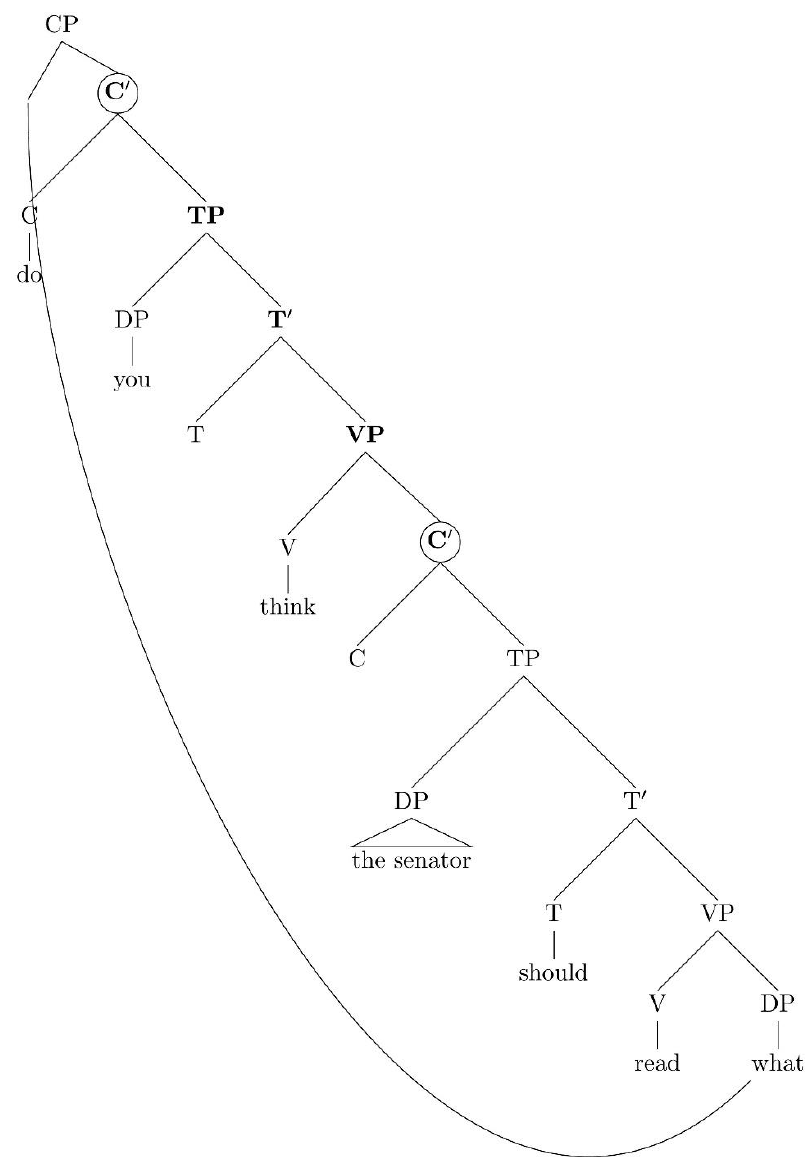
Figure 22. Derived tree for wh-interrogative featuring multidominance